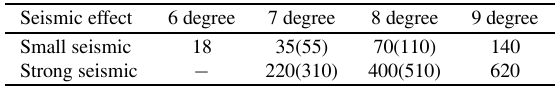
Table 4 Maximum acceleration value used in time-history analysis (cm/s 2